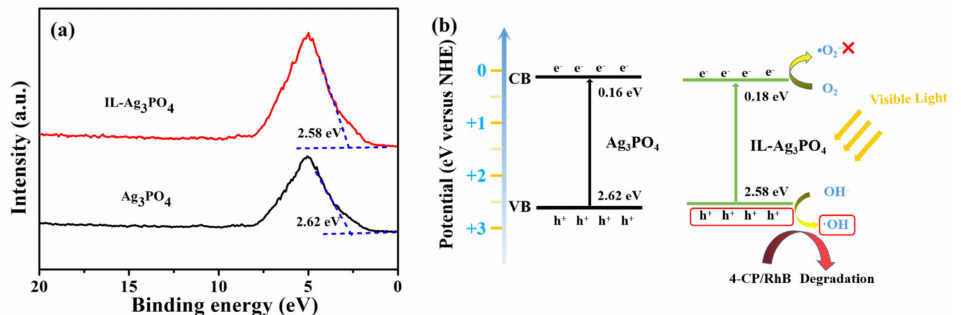
Figure 8. ( a ) XPS-valence spectra of Ag 3 PO 4 and IL-Ag 3 PO 4 ; ( b ) Schematic illustration of possible photocatalytic mechanism over IL-Ag 3 PO 4 under visible